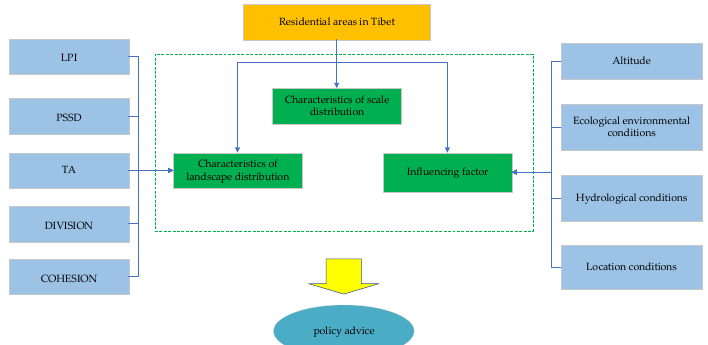
Figure 1. Research